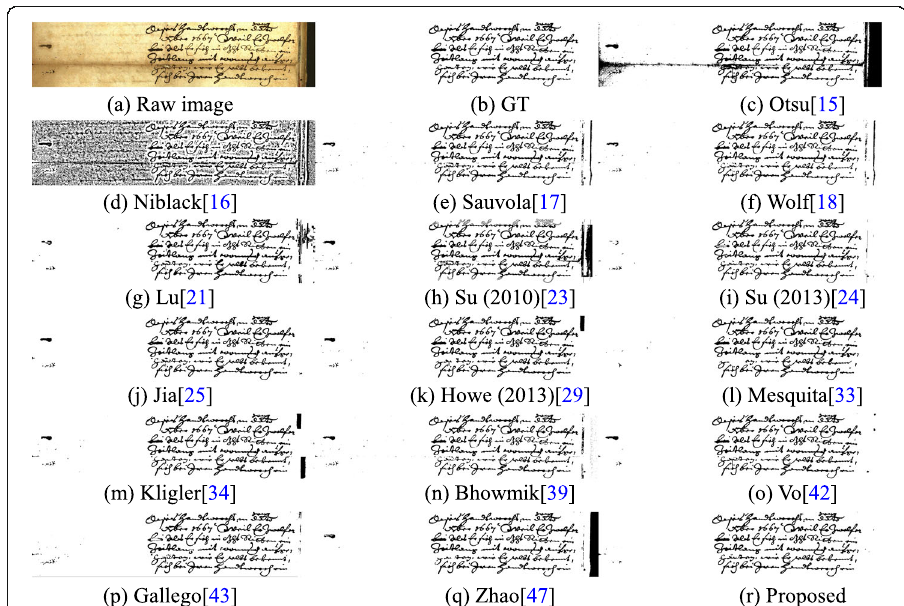
Fig. 8 Binarization results of selected methods for H06 in H-DIBCO